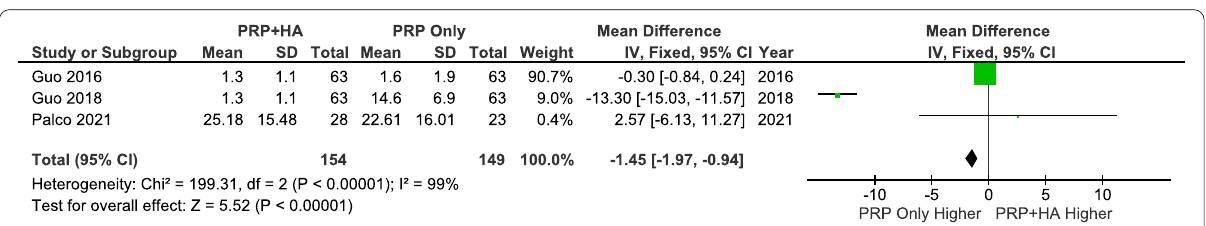
Fig. 8 Showing the Forest plot comparing the VAS scores between PRP